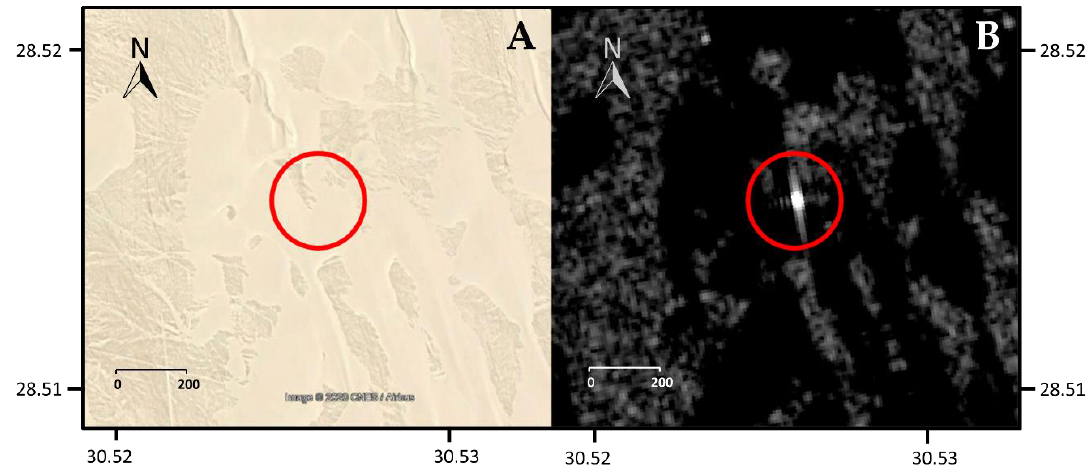
Figure 1. ( A ) Google Earth image over South Rayan dune field centered on latitude 28.51465, longitude 30.52506 in WGS84. ( B ) Sentinel-1 image over the same area showing a high backscatter, corner reflector-alike over a sand dune.